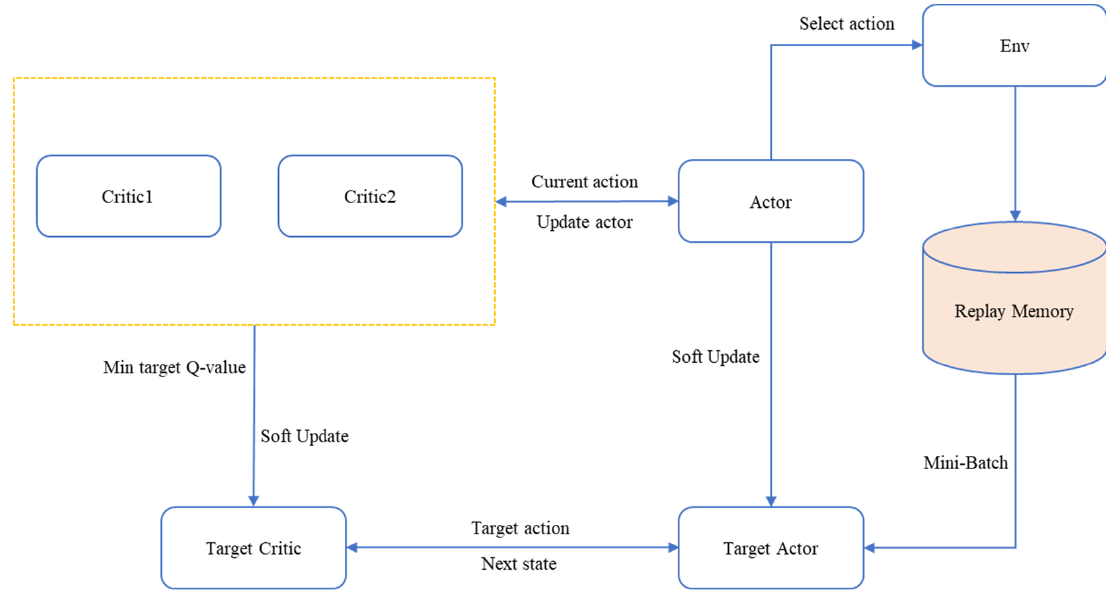
Figure 3. TD3 algorithm flowchart.